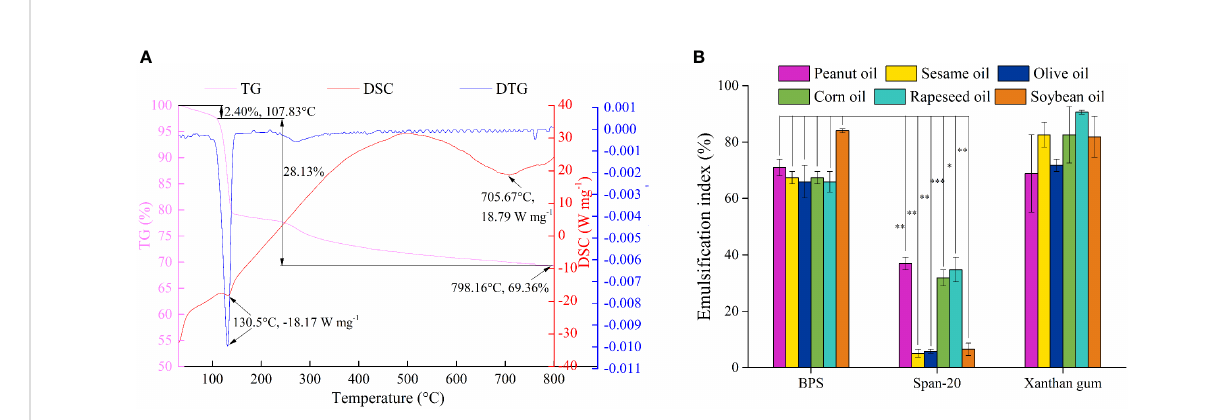
FIGURE 7 The TG (pink line), DSC (red line) and DTG (blue line) curves of BPS (A) . Emulsi fi cation performance of BPS, Span-20, and Xanthan gum in peanut oil, sesame oil, olive oil, corn oil, rapeseed oil, and soybean oil (B) . All values are mean values (n = 3) ( ∗ P < 0.05, ∗∗ P < 0.01, ∗∗∗ P <